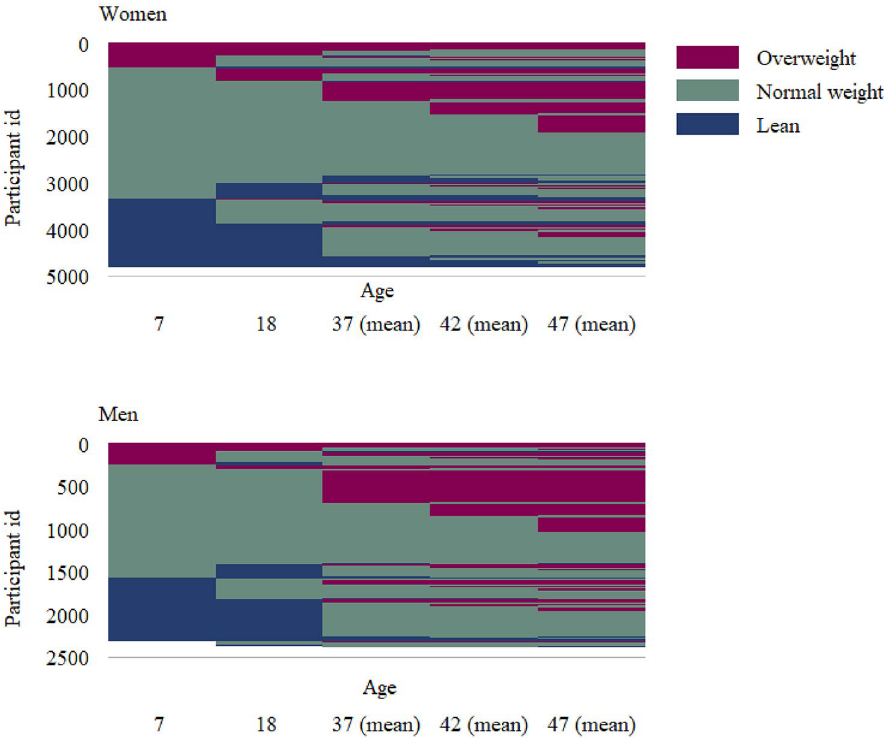
Figure 1. Individual weight categories at each of the study time-points. Categories of body weight were self- reported for childhood (7 years), adolescence (18 years), ten years before the study baseline (37 years in average) and five years before the study (42 years in average), and measured during the baseline examination (47 years in average). The individual participants are listed in the Y-axis; a change in color along time-points in the X-axis represents a change of category for an